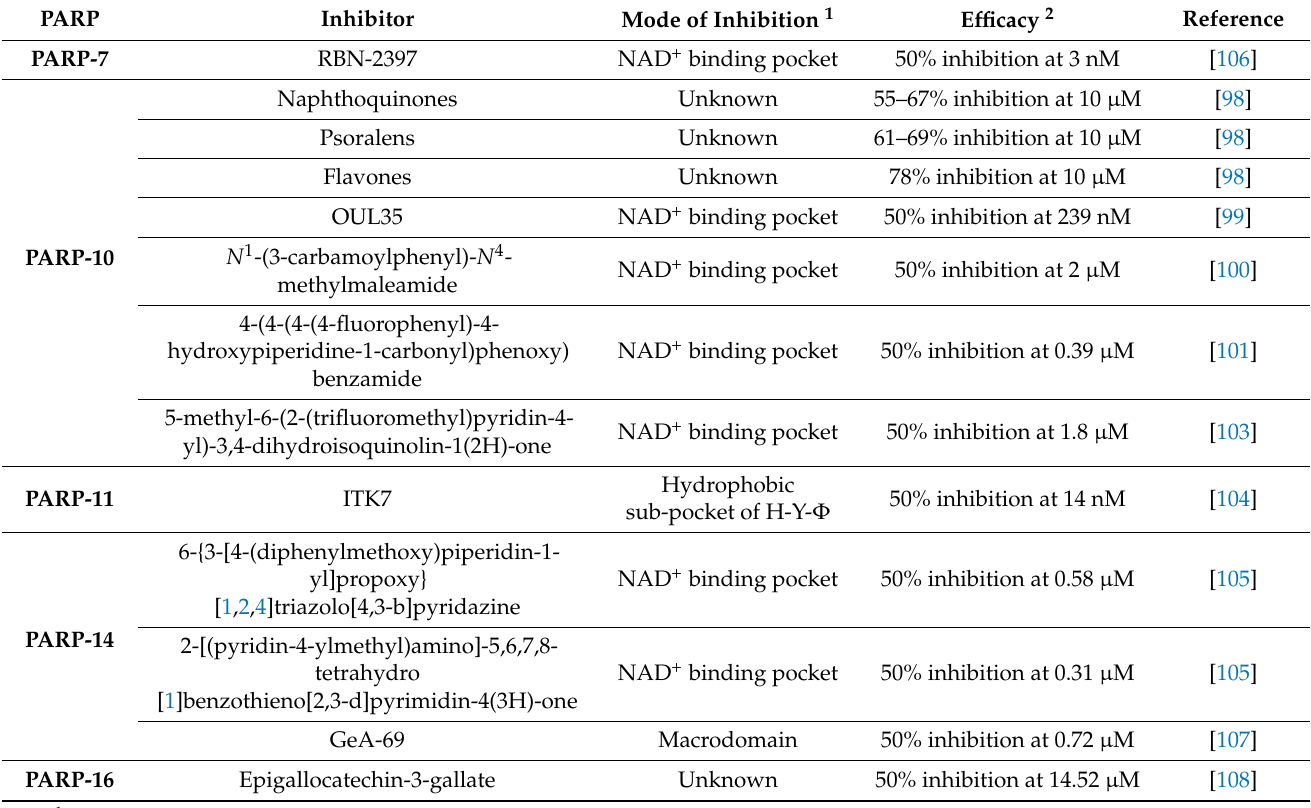
Table 2. Summary of MART